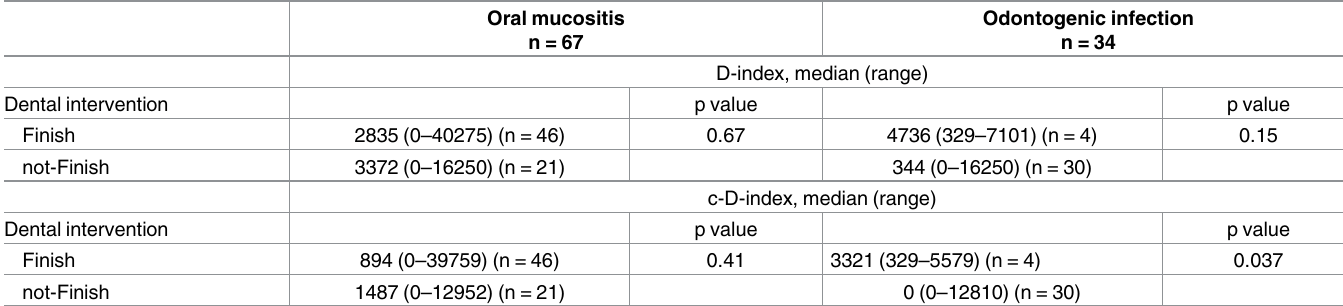
Table 4. Relationship between c-D-index and oral